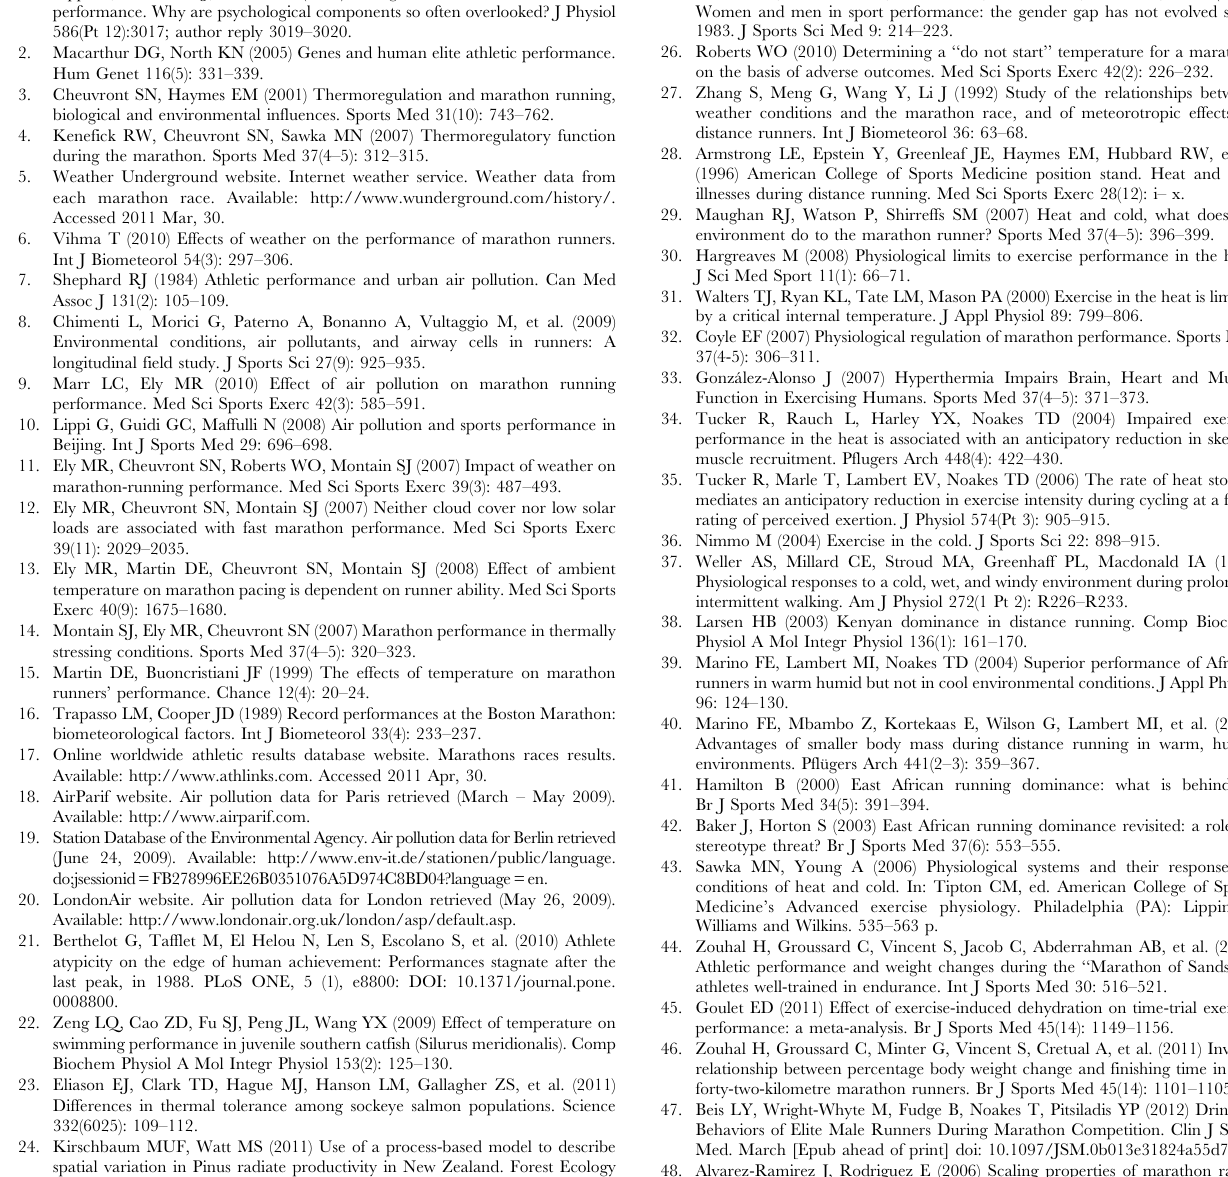
Table S3 Optimal temperatures for maximal